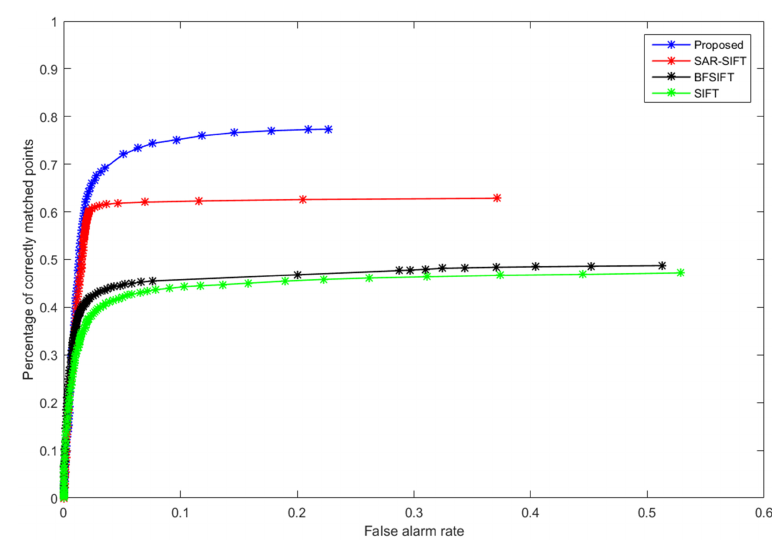
Figure 7. Global ROC curves of the proposed descriptor, SAR-SIFT, BFSIFT and SIFT.